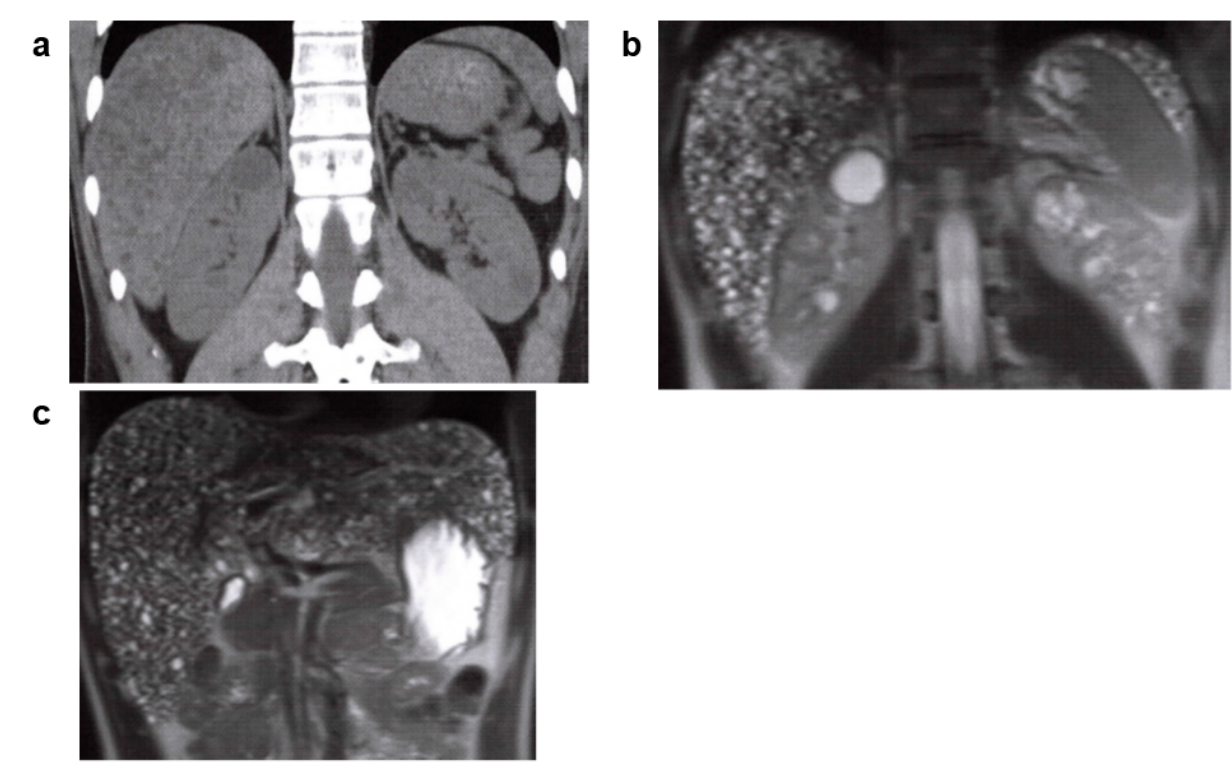
Figure 6. Autosomal recessive polycystic kidney disease (ARPKD): 30s, male, PKHD1 gene complex heterozygous mutation (compound heterozygous mutation), older brother had polycystic kidney disease (PKD) with end-stage kidney disease, no other family history (including parents) of PKD or end-stage kidney disease, no history of cerebral aneurysm or heart valve disease, kidney function eGFR 25.4 mL/min/1.73 m 2 (image provided by Toranomon Hospital). ( a ) Non-contrast CT image (coronal section): hepatomegaly with many microcysts of low density found on the liver. Multiple low-density cysts with a diameter of 1–3 cm are seen on the corticomedullary junction of both kidneys. ( b ) MRI T2-weighted image (coronal section): multiple hyperintense cysts with a diameter of 1–3 cm are seen near the corticomedullary junction of both kidneys. ( c ) MRI T2-weighted image (coronal section): multiple hyperintense microscopic hepatic cyst-like lesions are seen on the liver.